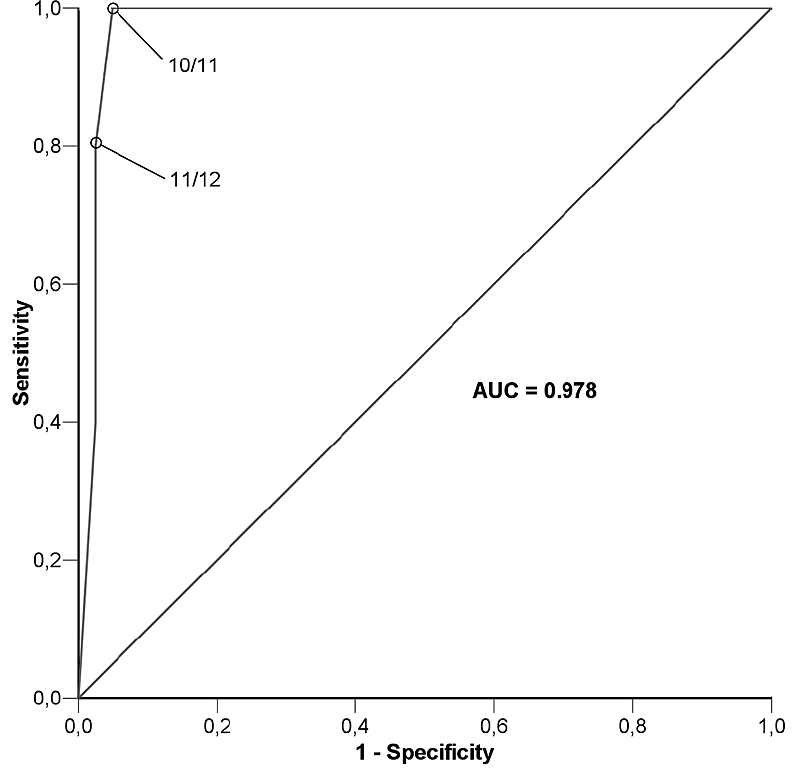
Fig. 1. Receiver operating characteristics (ROC) curve for the HADS. AUC = Area Under